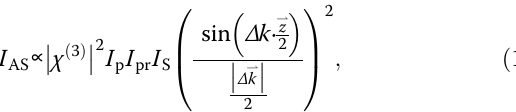
contribution due to CARS vibrational resonance as in − ω Fig. 1b ( ω = ω ). The second term is the nonreso- osc p S nant background signal and is independent of the Raman ≠ ω − ω shift ( ω ). The nonresonant background occurs osc p S because not all quantum pathways of the scattering process involve a resonance with a (ro-)vibrational state.